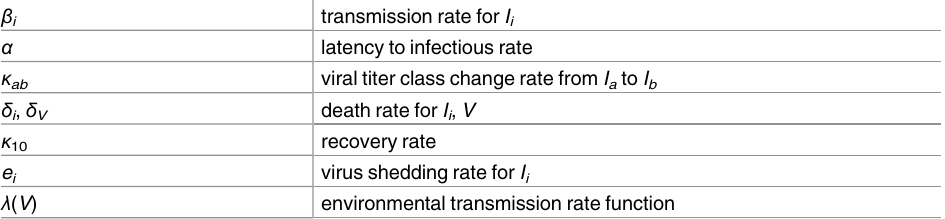
Table 1. Basic viral titer compartment transmission model